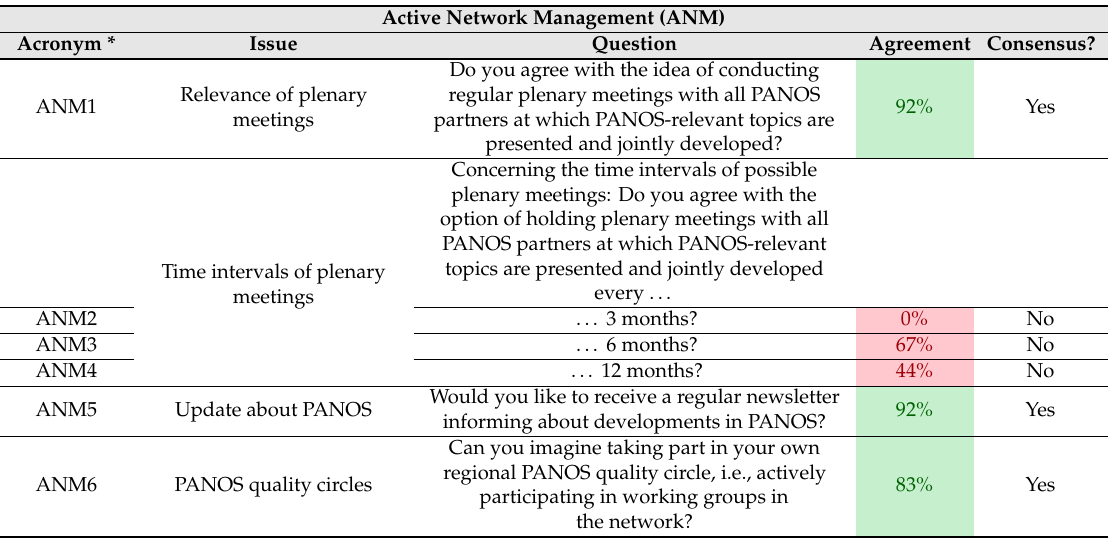
Table 7. Results of TED voting—network